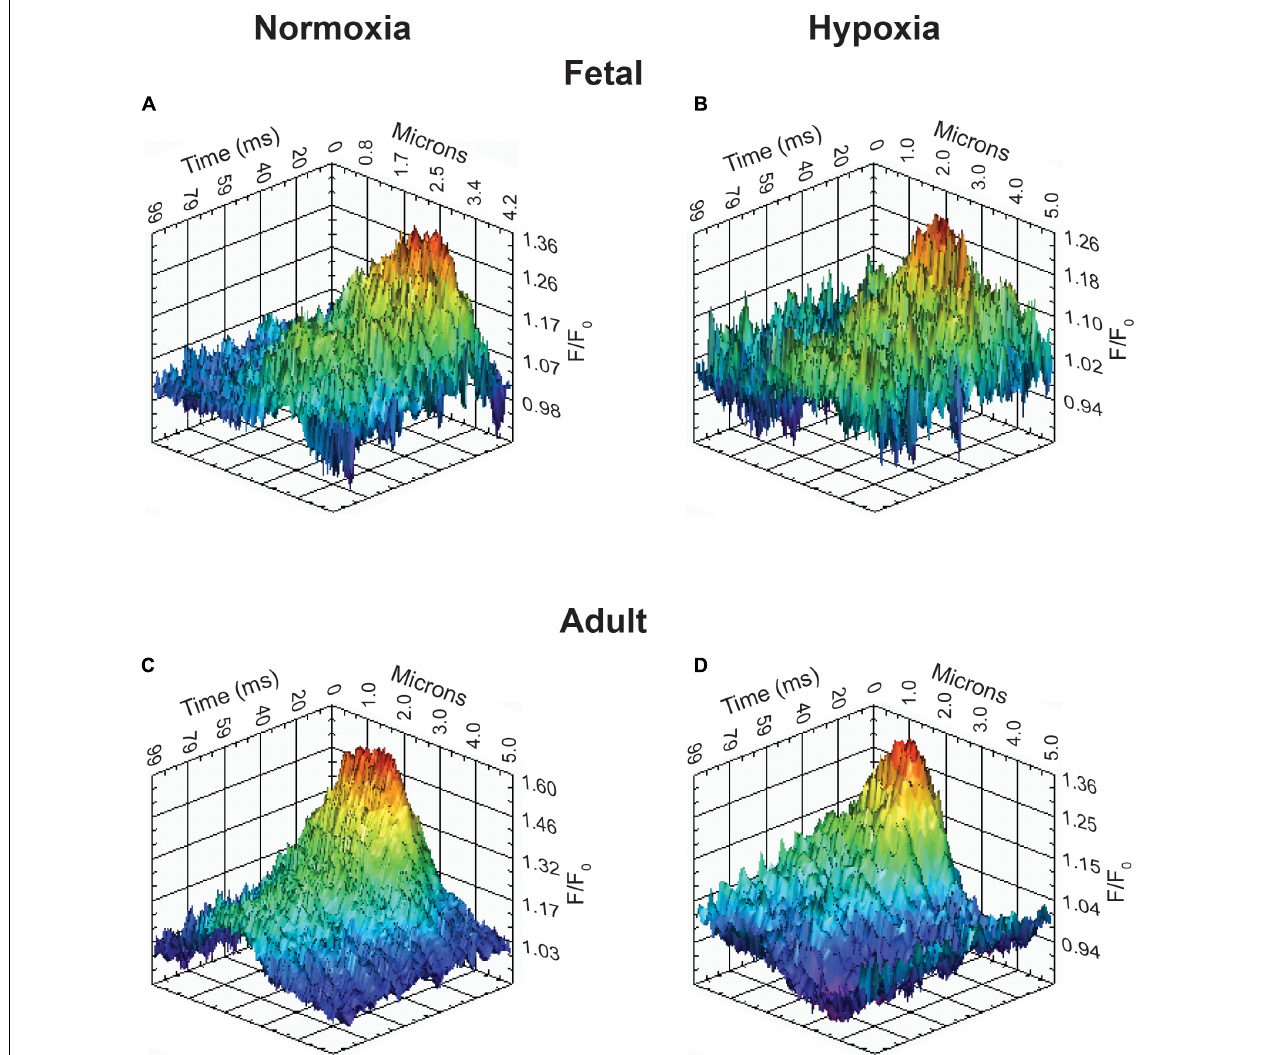
FIGURE 8 | Representative Ca 2 + spark tracings for basilar arterial myocytes from fetal and adult sheep. (A–D) Fluo-4 fluorescence tracings recorded from basilar arterial myocyte line scans of fetal and adult sheep under normoxic and hypoxic conditions analyzed with SparkLab 4.3.1